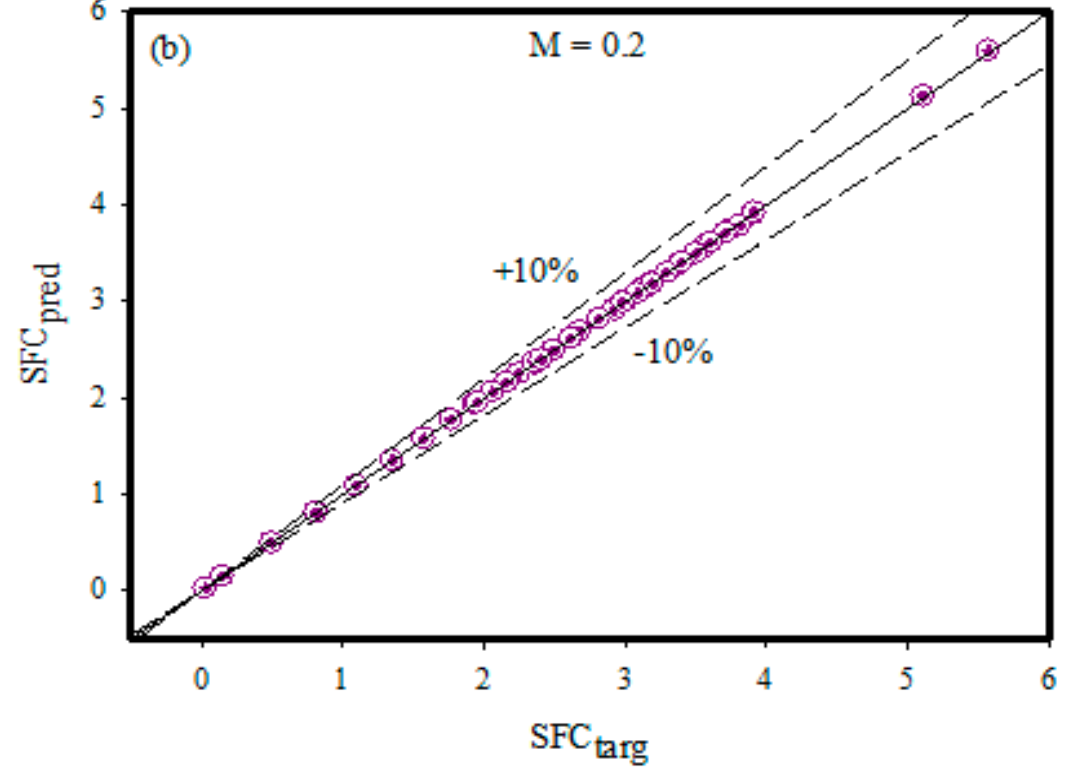
Figure 9. ( a , b ). Target and prediction values for M = 0 and M = 0.2. Table 11. The performance parameters calculated for the two different ANN models. Model MSE R MoD min (%) MoD max (%) Model 1 ( M = 0) Model 2 ( M = 0.2)